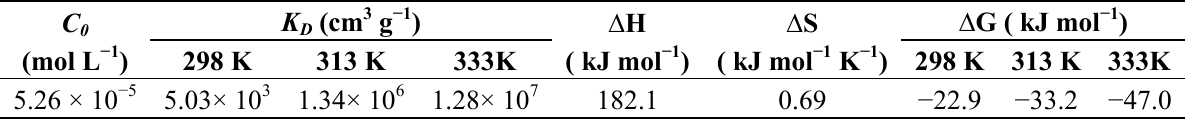
Table 4. Thermodynamic parameters for P adsorption on EAF